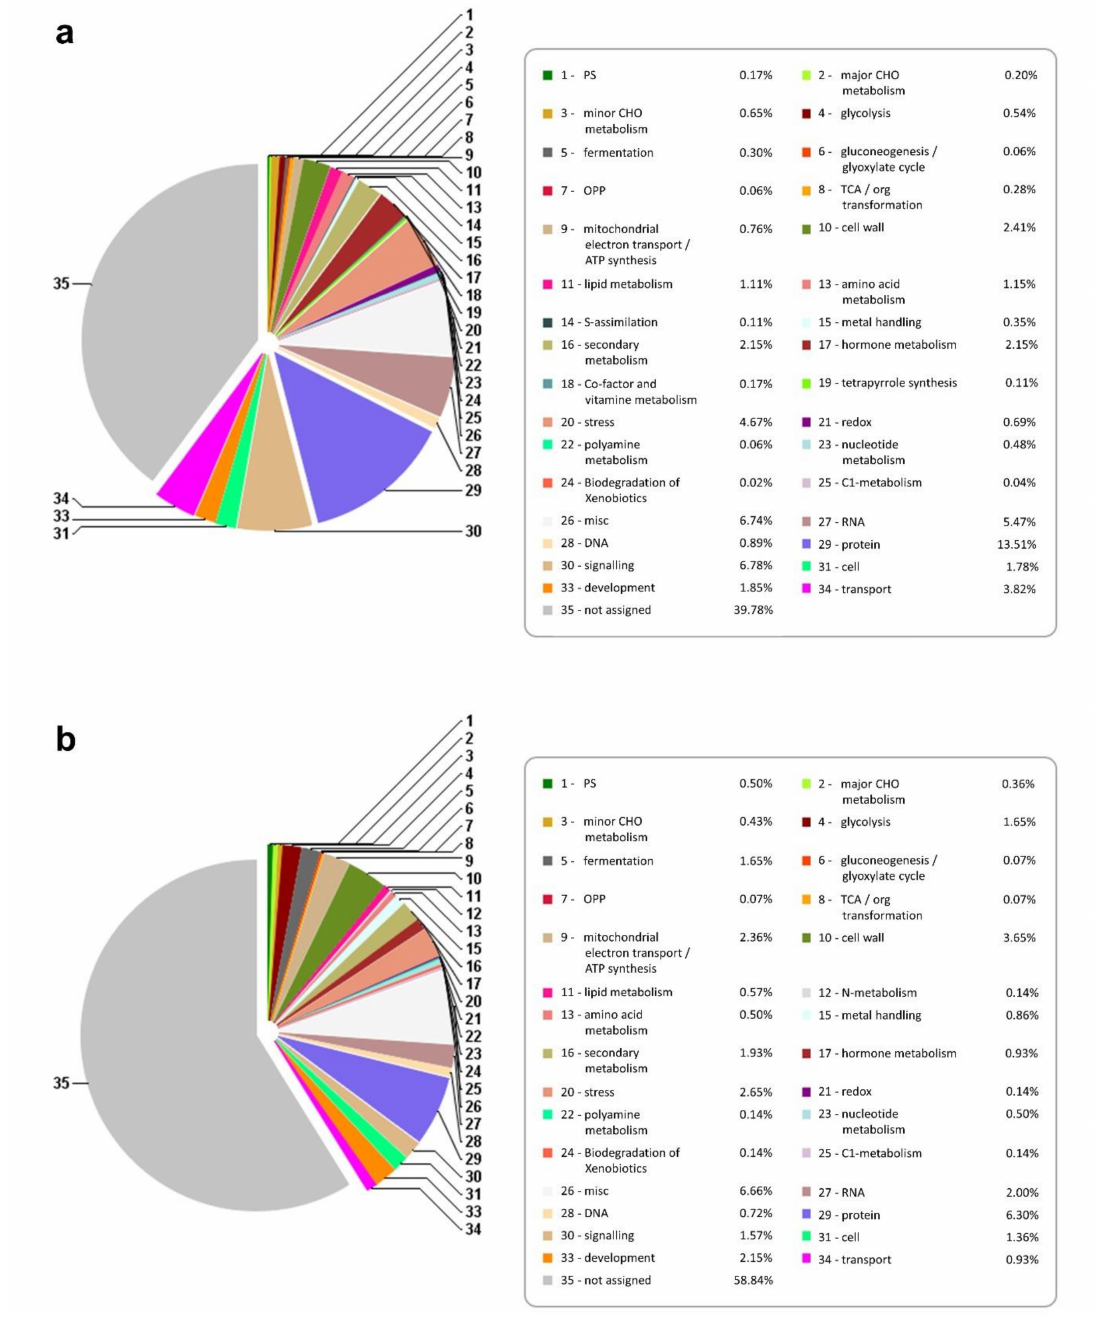
Figure 2. Mercator annotation of di ff erentially expressed contigs in ( a ) TAS and ( b )